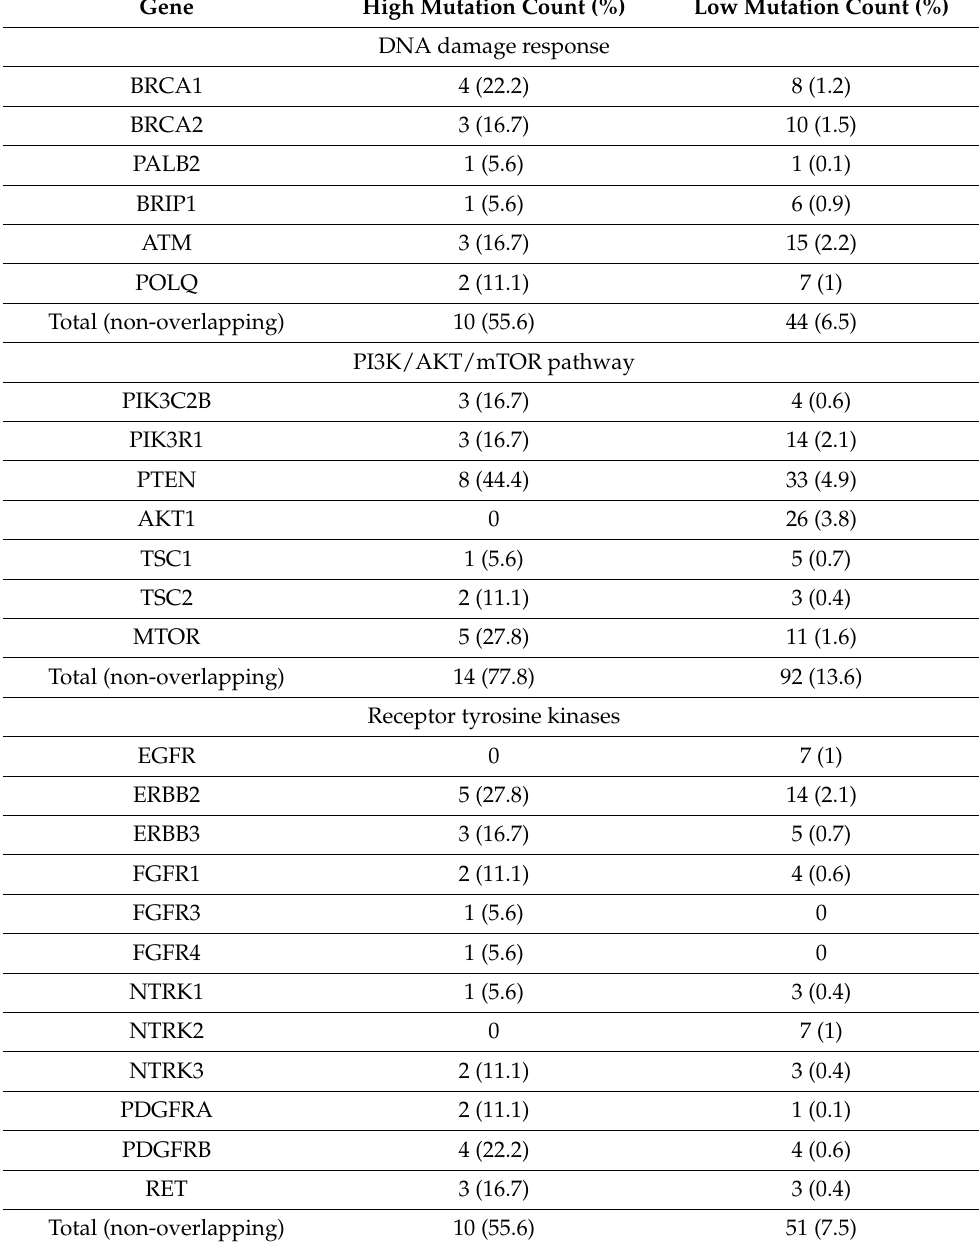
Table 2. Mutated genes with possible therapeutic interest in the high ( n = 18) and low mutation ( n = 678) count groups in patients with luminal cancers from the breast cancer TCGA study. In parentheses are